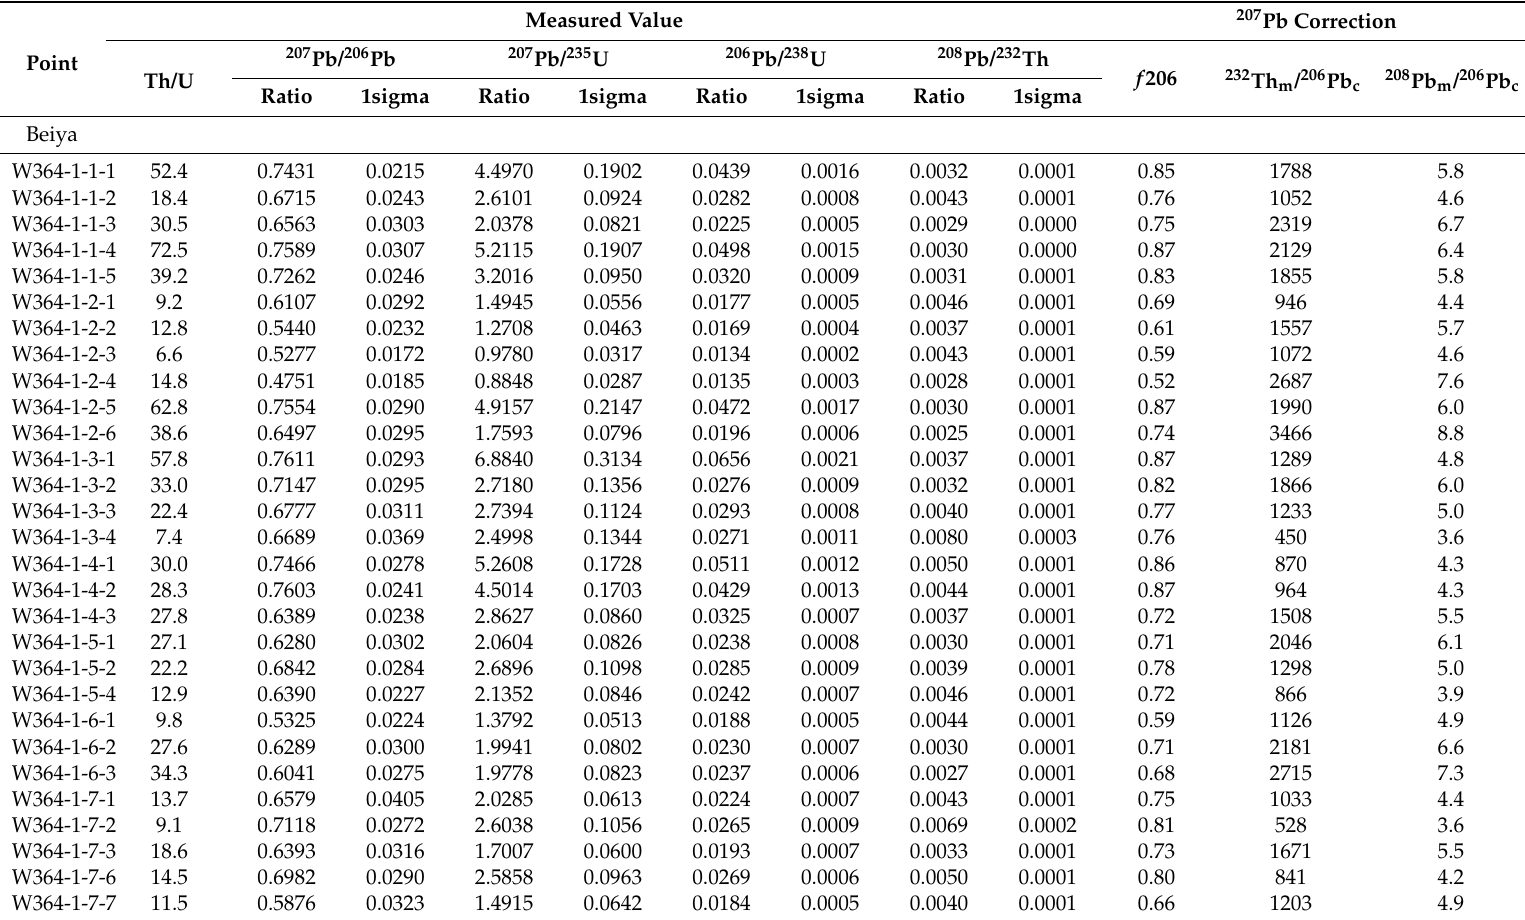
Table A3. LA-ICP-MS U-Th-Pb isotope data for allanite from the Beiy and Machangqing